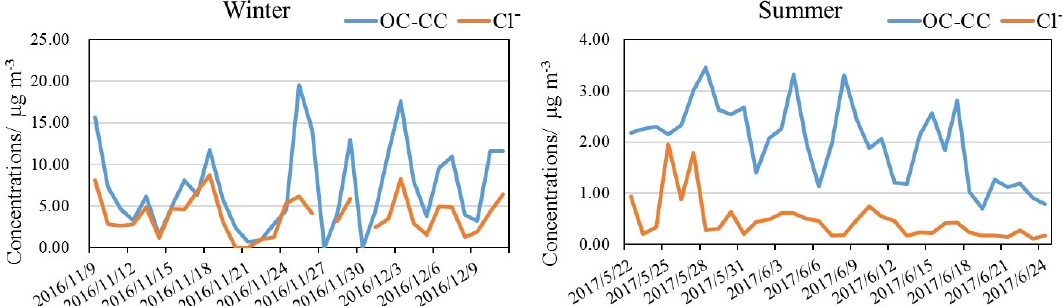
Figure 5. Time series of OC from coal combustion (OC-CC) and Cl − in winter and summer in